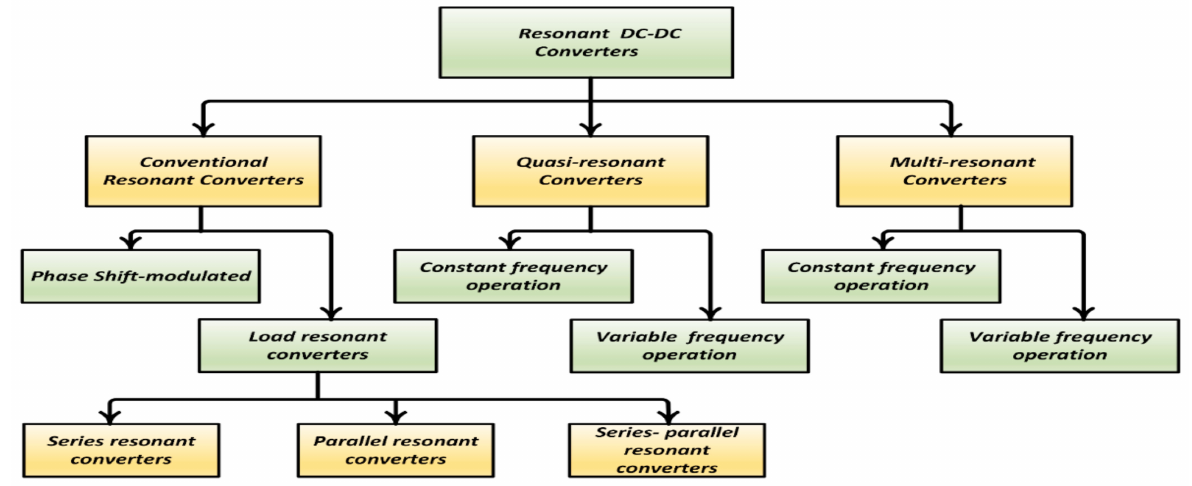
Figure 23. Classification of resonant DC-DC converter